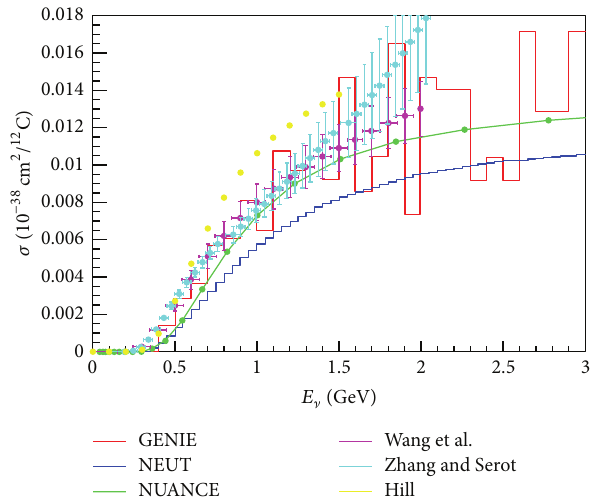
Figure 9: (Color online) A comparison of the total cross section of NC photon production per 12 C nucleus [68]. The neutrino interac- tion generators used by experimentalists (GENIE [13], NEUT [14], and NUANCE [11]) tend to predict lower cross sections than state- of-the-arttheoreticalmodels(Wangetal.[65],ZhangandSerot[69], Hill [64]).